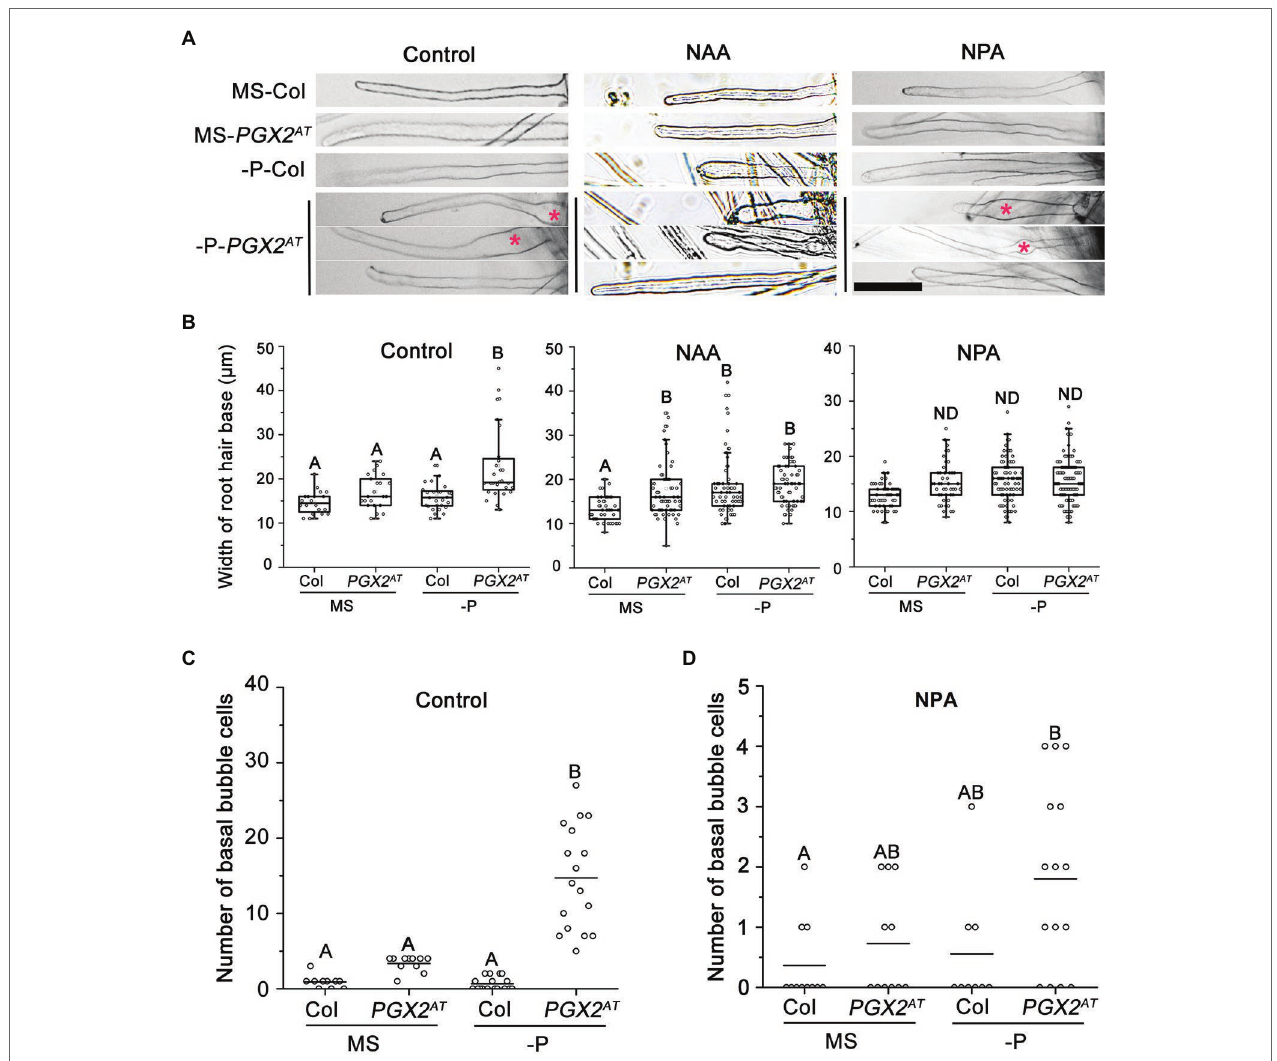
FIGURE 4 | NAA/NPA treatments inhibit bubble-like phenotype in root hair bases of PGX2 AT seedlings. (A) Both NAA and NPA treatments resulted in the occurrence of a few bubble-like root hairs at the top or middle under phosphate deficient (-P) conditions. Bars = 100 μ m. (B) Widths of root hair bases in Col and PGX2 AT seedlings grown in MS control and phosphate deficient (-P) conditions with NAA or NPA application ( n ≥ 20 root hairs from at least 7 seedlings). (C,D) Number of basal bubble-like cells in Col and PGX2 AT seedlings grown in MS control and phosphate deficient (-P) conditions without (Control) or with NPA application ( n ≥ 9 seedlings). Uppercase letters indicate significantly different groups as determined by one-way ANOVA with post-hoc Duncan’s test ( p < 0.01). ND, no statistical